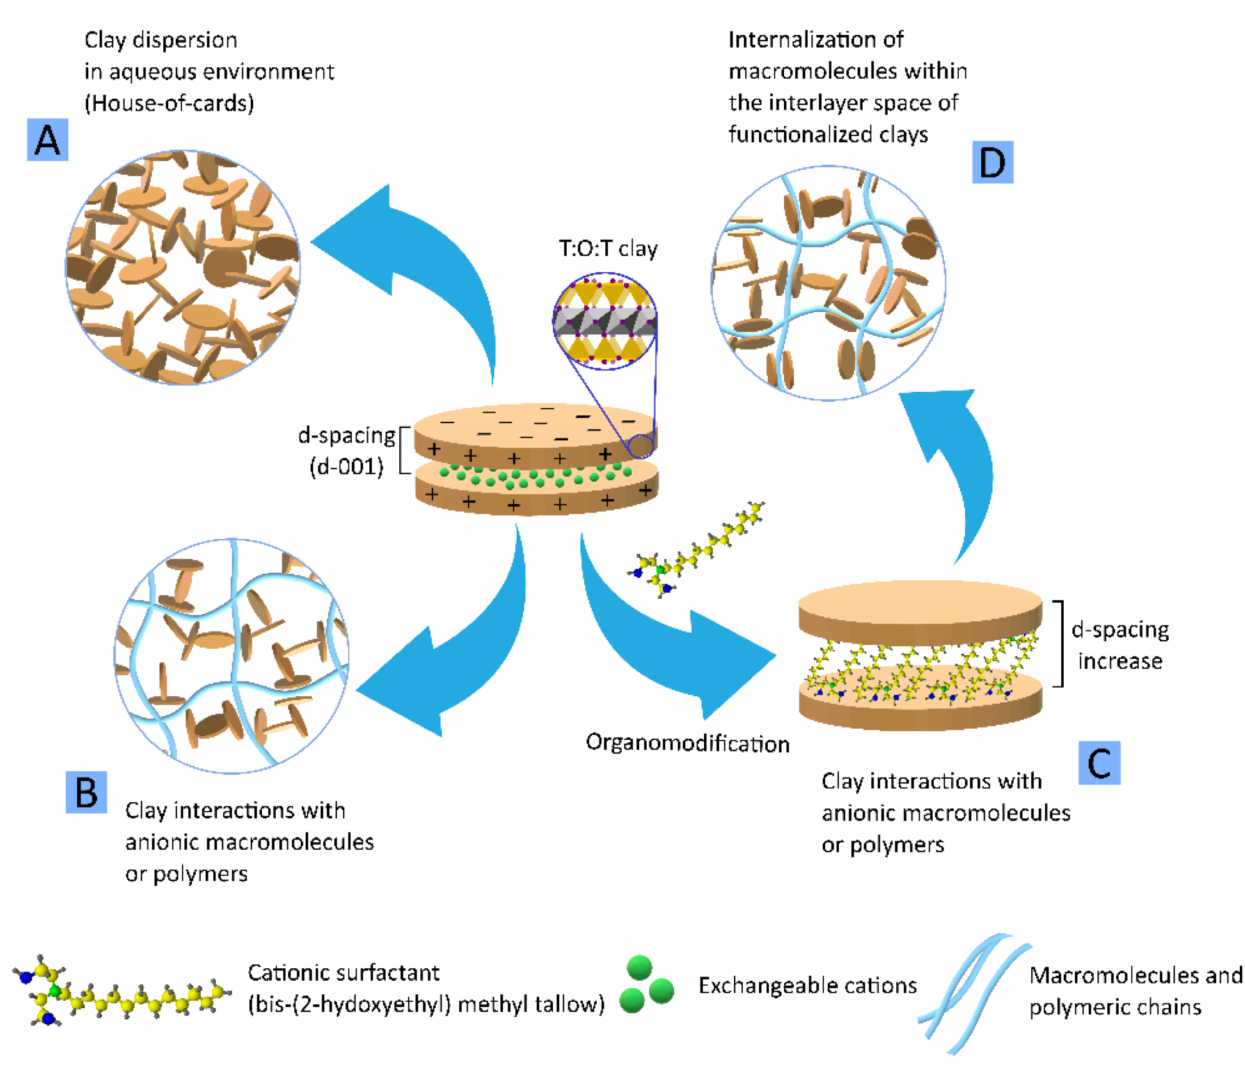
Figure 12. Schematic representation of layered clay nanoplatelets structure and charges (central). ( A ) House-of-cards inter- actions of clay nanoparticles in aqueous suspension after proper, homogeneous dispersion. ( B ) Clay particles interactions with anionic macromolecules in an aqueous environment. The clay–polymer–clay interactions mediate the crosslink- ing process. ( C ) Functionalization/organo-modification of layered clay mineral with an example of cationic surfactant. ( D ) Schematic representation of neutral/cationic macromolecules “sandwiched” between layered clay nanoplatelets. The increase in d-spacing after organo-modification makes clay particles more prone to intercalate molecules such as polymers and